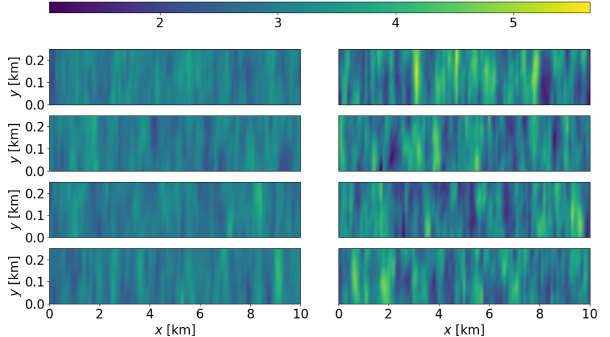
Figure 3. Samples of the Glen’s flow law exponent for Example 2. Left column: samples for Example 2a. Right column: samples for Example 2b. The samples in the top row are taken as the true Glen’s flow law exponents. Note that the axes have been stretched in the y direction for ease of visualization.